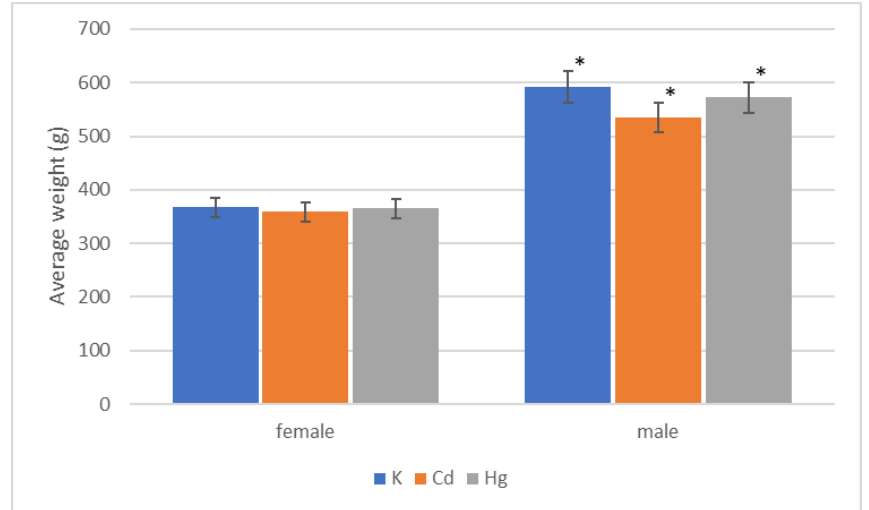
Figure 1. A comparison of weights after 52 weeks of the experiment. * p < 0.001, for all male groups compared to corresponding female groups; n = 8 per group.